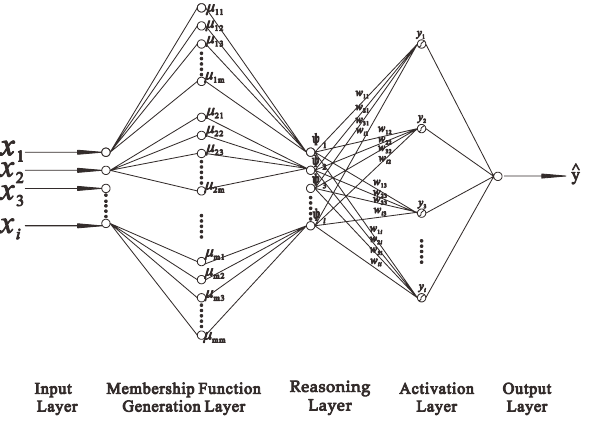
Figure 2. Optimized and improved neural network